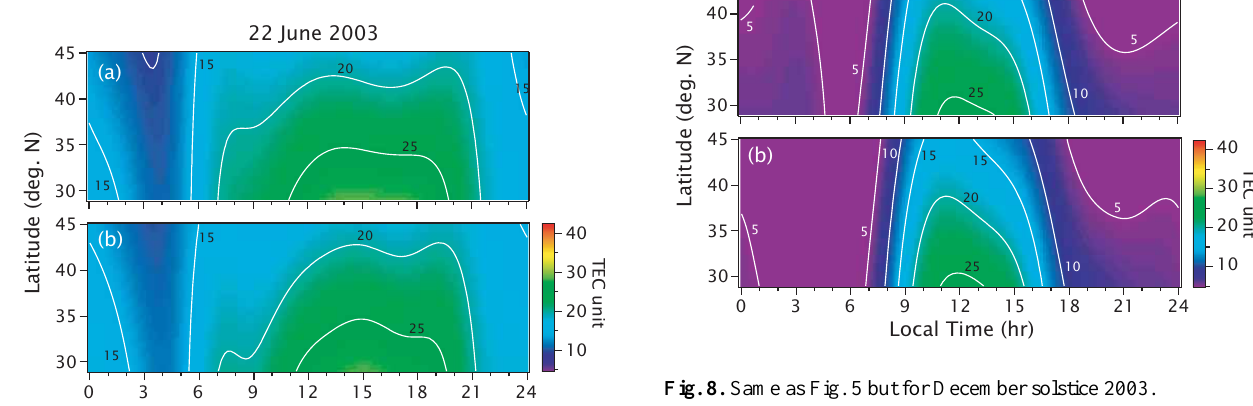
For more comparisons, the TECs at noon at grid point 14 (35 ◦ N, 137 ◦ E) near central Japan, as denoted by the asterisk in Fig. 1, were calculated and are shown in Fig. 9. The top panel is the solar activity inputs, F10.7 (upper traces) and R (lower traces), averaged over three days (dots connected with thin lines) and three solar rotations (solid lines). The middle panel is the grid TECs (circles connected with thin line) and network outputs (thick solid line). Not only seasonal varia- tions, but also solar activity dependences are reproduced by the network. Interestingly, at the end of October, the solar flux was quite large, but the grid TEC did not increase very much. This was well reproduced by the network. When the solar activity indices averaged over three solar rotations were not incorporated into the input parameter, this moderate in- crease in TEC against the extremely intense solar activity at the end of October was not successfully reproduced. On the other hand, the enhanced grid TEC found in the latter half of May was not reproduced by the network. In this period, the solar activity was not so high as compared with the so- lar activity in the solar rotation before and after this